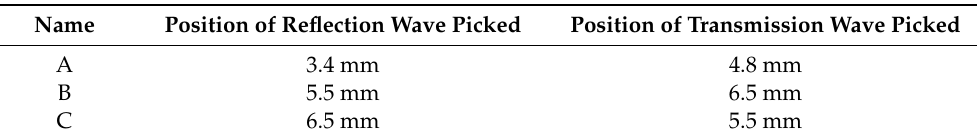
Table 5. Positions for Pair A, B and C.